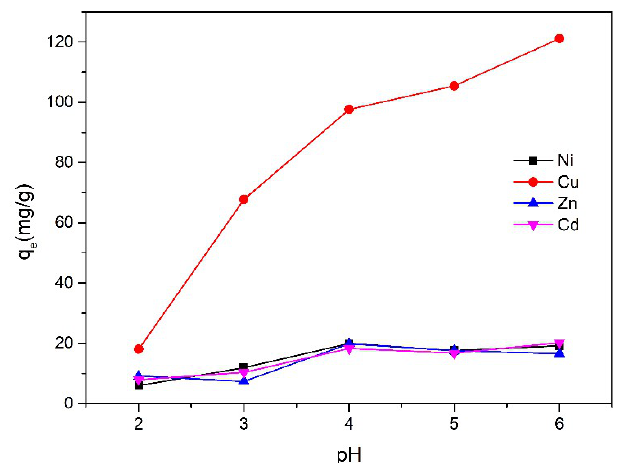
Figure 6. Effect of pH in a quaternary metal system. Reaction conditions: T = 293 K, [Cu(II)] 0 = [Zn(II)] 0 = [Ni(II)] 0 = [Cd(II)] 0 = 200 mg/L, reaction time = 12 h.